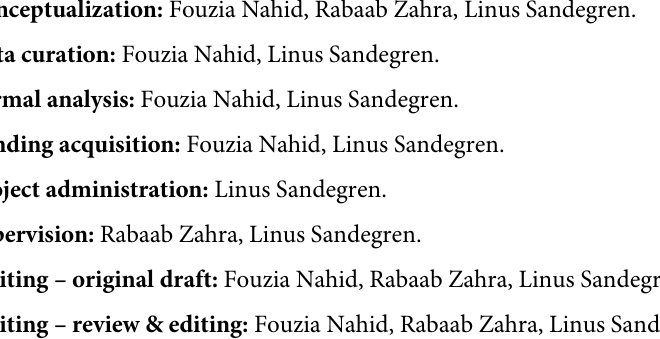
S1 Table. Single nucleotide polymorphisms between DA48896 and MS6671. S2 Table. Chromosomal structural variations between DA48896 and MS6671. S3 Table. Structural variations between